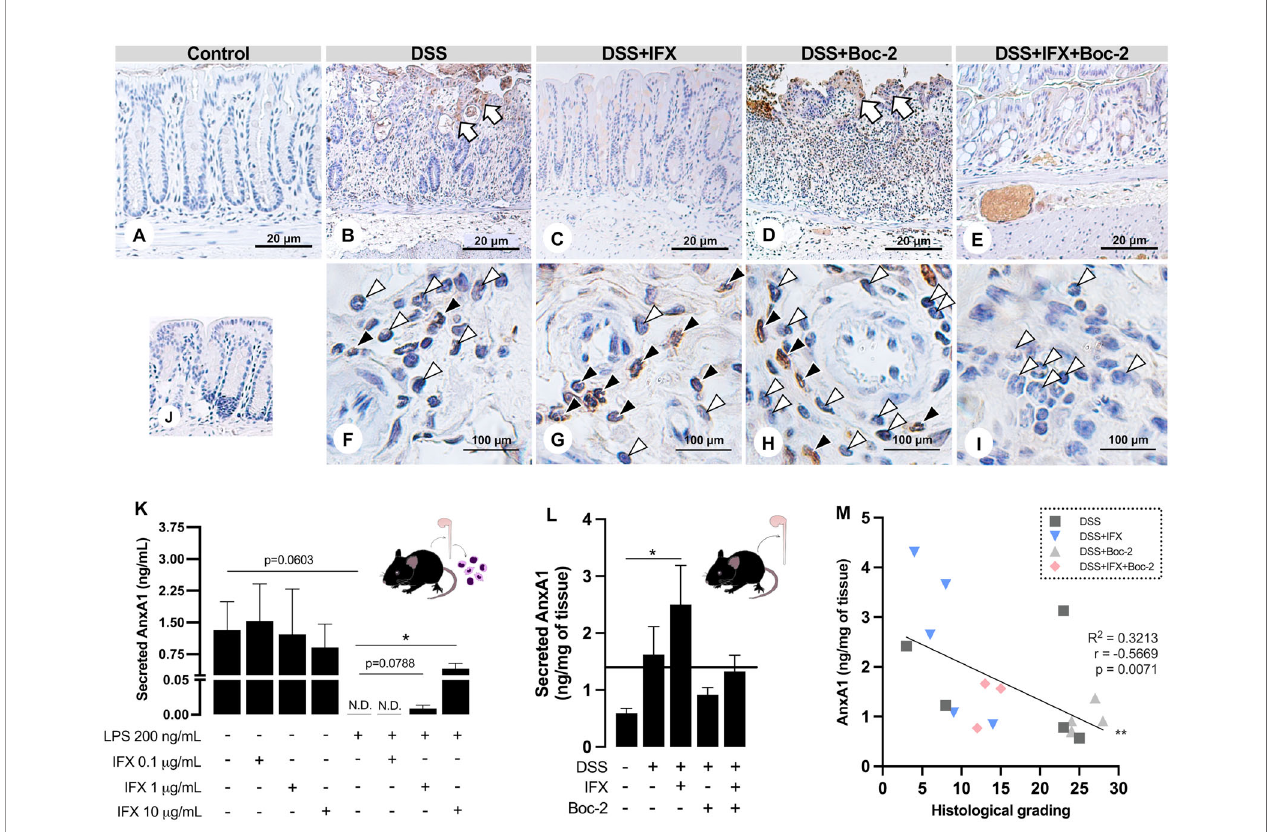
FIGURE 4 | In fl iximab (IFX) induces annexin A1 (AnxA1) expression and secretion by in fi ltrated leukocytes during in fl ammation. (A – E) AnxA1 expression in the epithelial barrier from wild-type (WT) mice colon. AnxA1 concentrated on the wound bed ( white arrows ). (F – I) Immunostaining for AnxA1 in submucosal leukocytes. Tissue leukocytes positive ( black arrowheads ) or negative ( white arrowheads ) for AnxA1 staining. (J) Reaction control. Counterstaining, hematoxylin; embedding, paraf fi n; sections, 3 m m. Bars , 20 m m (A – E) and 100 m m (F – I) . (K) AnxA1 secreted by lamina propria leukocytes cultured ex vivo . (L) AnxA1 secreted by colon explants in culture. (M) Moderate negative correlation between AnxA1 secreted into the tissue and histological grading. N.D. , non-detected. * p < 0.05, ** p < 0.01. n = 3 – 4 mice/group (K) ; n = 4 – 6 mice/group (L) . Results are expressed as the mean ±